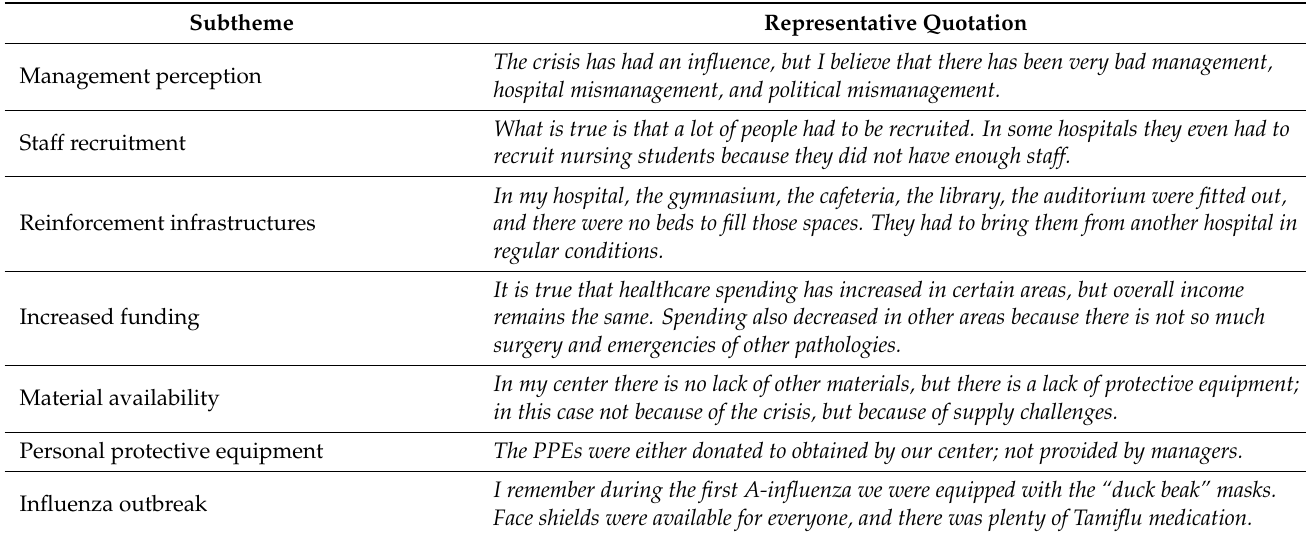
Table 4. Subthemes and representative quotations for the main theme “Crisis management and increased funding in response to